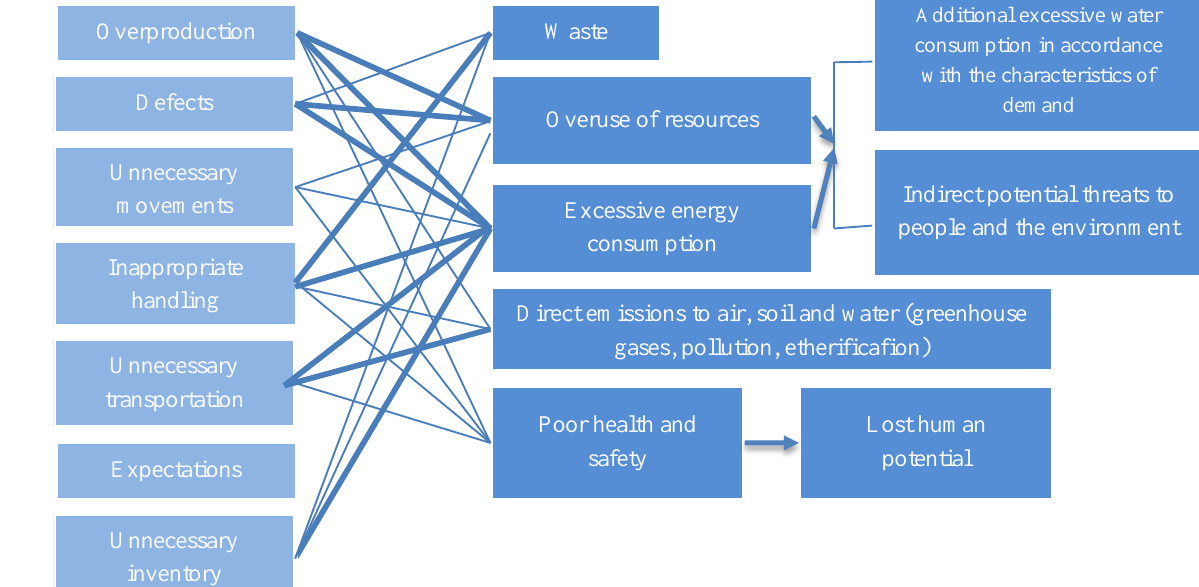
Figure 4. Causal relationships between lean construction and environmental